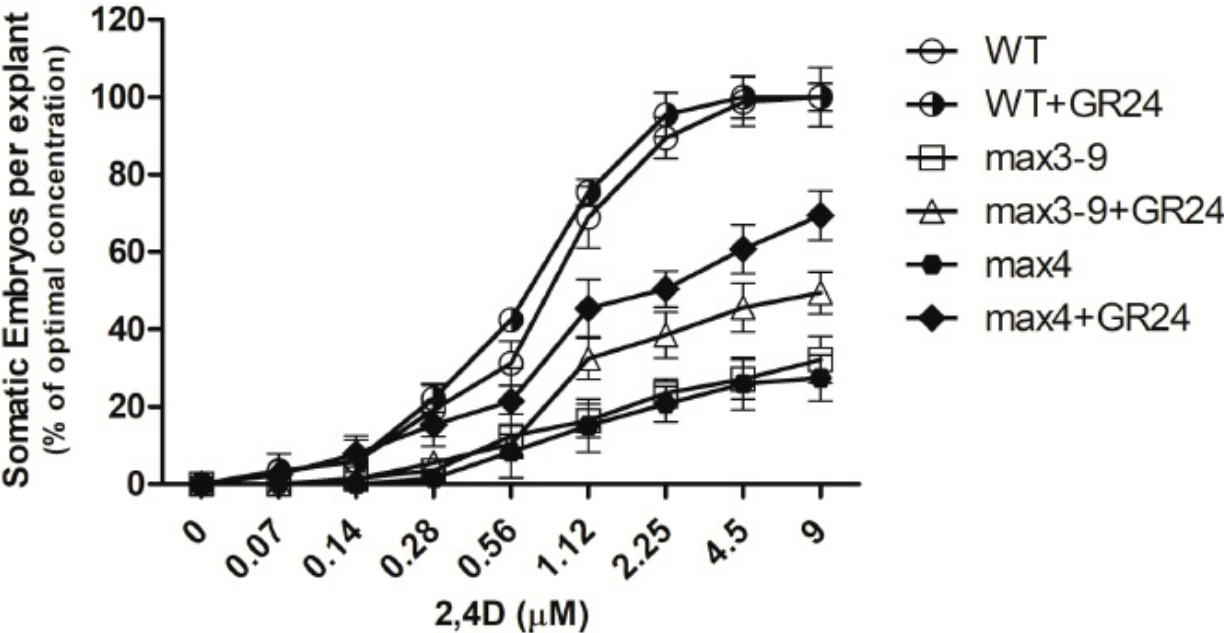
Figure 6. Effects of different concentration of 2,4-D on the number of somatic embryos generated from WT, max3–9 , and max4 explants. Tissue was also treated with GR24 (50 nM). Values are means ± SE of three biological replicates ( n = 15). Letters on bars indicate statistically significant differences ( p < 0.05).